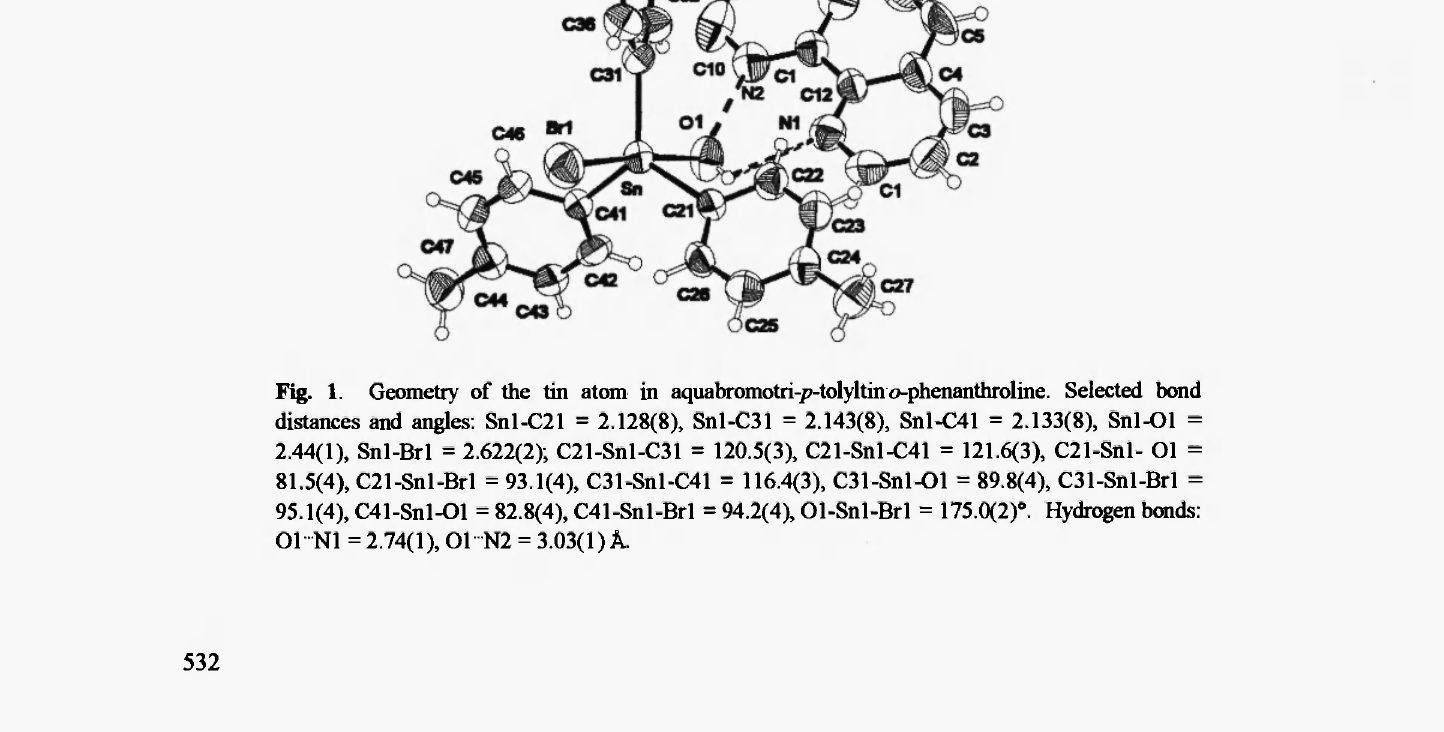
Fig. 1. Geometry of the tin atom in aquabromotri-/7-tolyltin o-phenanthroline. Selected bond distances and angles: Snl-C21 = 2.128(8), Snl-C31 = 2.143(8), Snl-C41 = 2.133(8), Snl-Ol = 2.44(1), Snl-Brl = 2.622(2); C21-Snl-C31 = 120.5(3), C21-Snl-C41 = 121.6(3), C21-Snl- Ol = 81.5(4), C21-Snl-Brl = 93.1(4), C31-Snl-C41 = 116.4(3), C31-Snl-01 = 89.8(4), C31-Snl-Brl